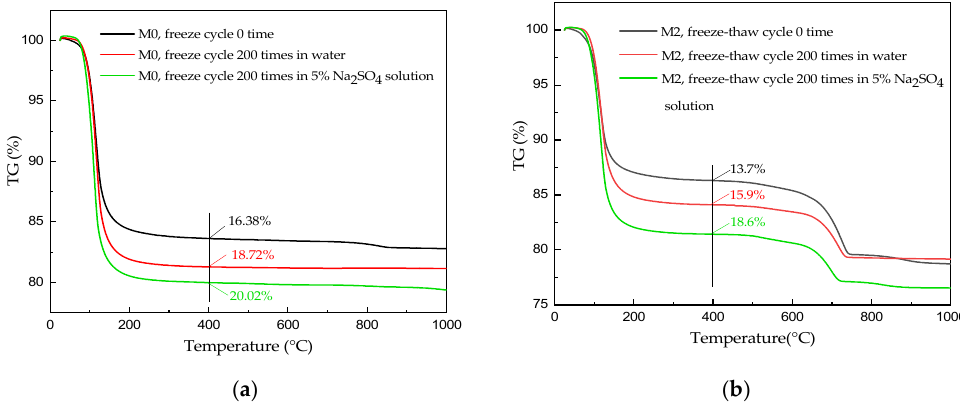
Figure 6. TG spectra of MKPC specimens ( a ) M0 and ( b ) M2.